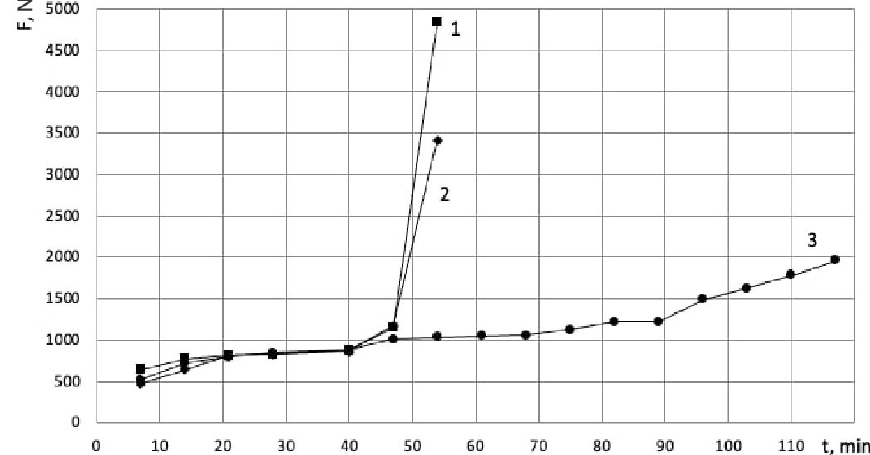
Figure 11. Graph of the dependency of the cutting forces vs. machining pattern: 1—cutter No. 1; 2—cutter No. 2; 3—cutter No. 3.